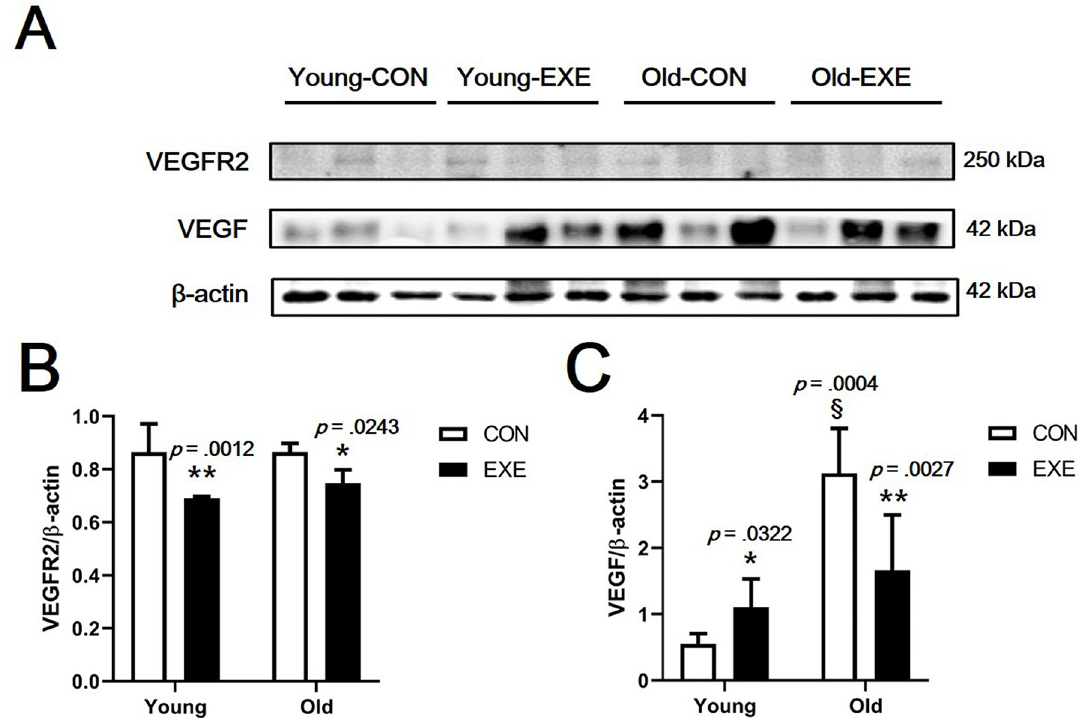
Fig 6. Expression of angiogenesis-related proteins in blood vessels of mice subjected to LSE. (A) Western blotting band images (results of angiogenesis-related proteins in carotid artery). (B) VEGFR2 expression level. (C) VEGF expression level. All data are presented as the mean ± SD vs. control group of same age, � p < 0.05 and �� p < 0.01; vs. control group of different age, § p < 0.001.